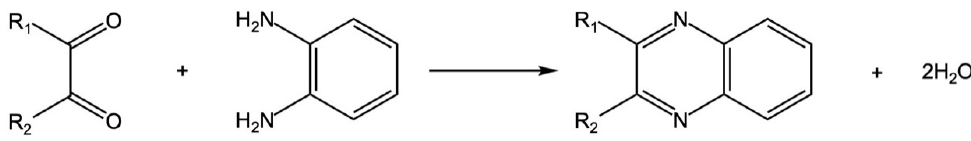
Figure 1. The reaction equation of OPD and α -DCs. Figure 11. α -DCs react with L-phenylalanine to produce phenylacetaldehyde.